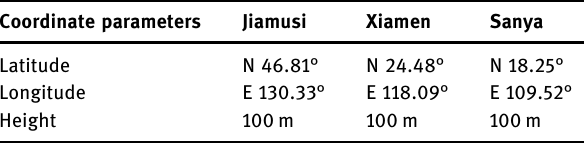
Table 3: Coordinates of stations in the simulation scene Coordinate parameters